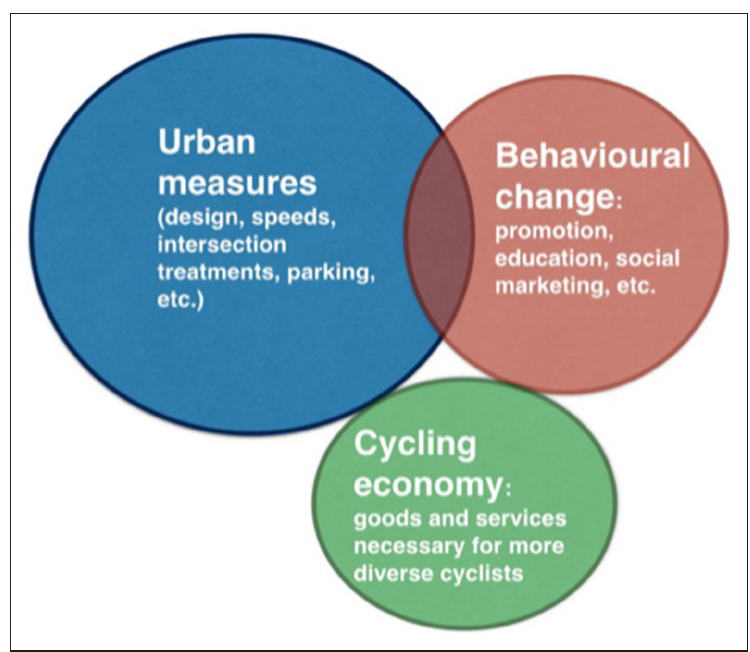
Figure 1: Interactions, urban measures, behavioural change and cycling